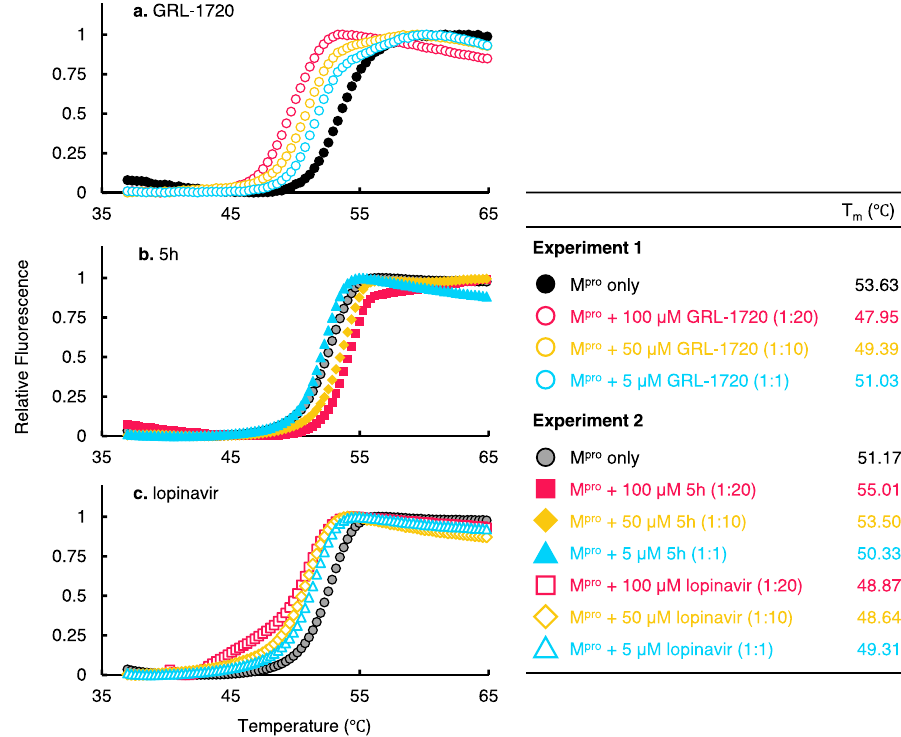
Fig. 8 Thermal stability of M pro in the presence or absence of 5h. Thermal stability of M pro in the presence of GRL-1720 ( a ), 5h ( b ), and lopinavir ( c ) using differential scanning fl uorimetry (DSF) was determined. Note in Experiment 1 that the T m value of M pro alone was 53.63 °C, while in the presence of 50 and 100 µ M of GRL-1720, the values decreased to 49.39 and 47.95 °C, respectively, suggesting that the thermal stability of M pro decreased when GRL- 1720 bound to M pro , suggesting that GRL-1720 formed covalent bond with M pro . In experiment 2, the T m value of M pro alone was 51.17 °C, while in the presence of 50 and 100 µ M of 5h, the values increased to 53.50 and 55.01 °C, respectively, suggesting that the thermal stability of M pro increased when 5h bound to M pro . When M pro was treated with 50 and 100 µ M lopinavir, decrement was seen with the T m values with 48.64 and 48.87, suggesting that lopinavir non-speci fi cally bound to M pro (see the Results section). These data with the x-ray crystallographic analyses 5h strongly interacts with M pro and potently inhibits its enzymatic activity as compared to GRL-1720. All the fi gures were generated with Microsoft